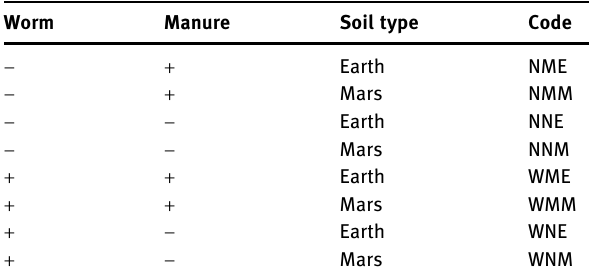
For soil type Earth indicates application of Earth soil and Mars indicates application of Mars soil simulant MMS. The code for the treatments is used in all other tables and fi gures.